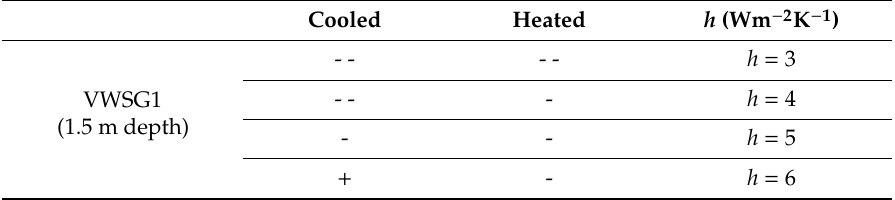
Table 3. Curve matching conditions for different h values at each VWSG.